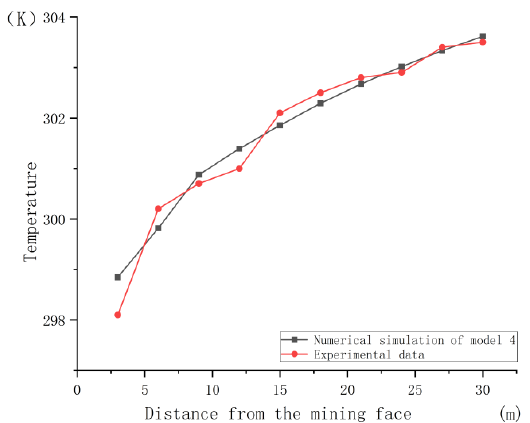
Figure 22. Comparison of experimental and numerical simulation results.